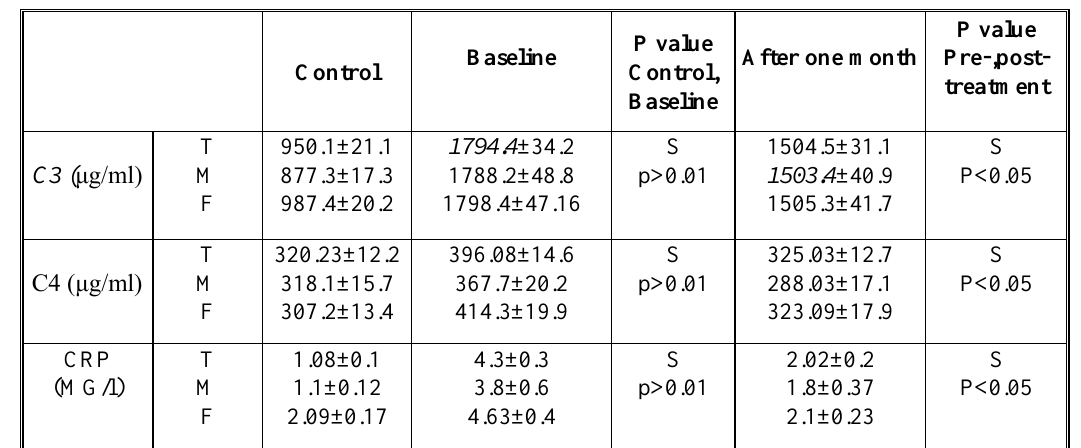
Table (1): The serum level of C3,C4 and CRP before using CQP at baseline and after one month of the